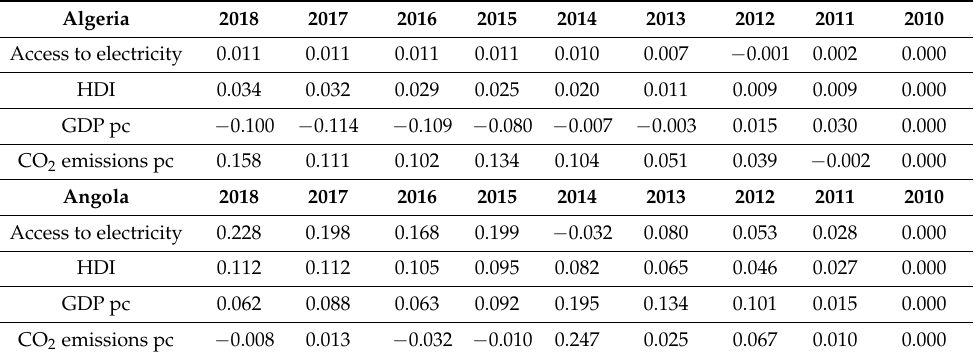
Table 7. The results of the second stage of standardization for model (c) for two selected African countries.